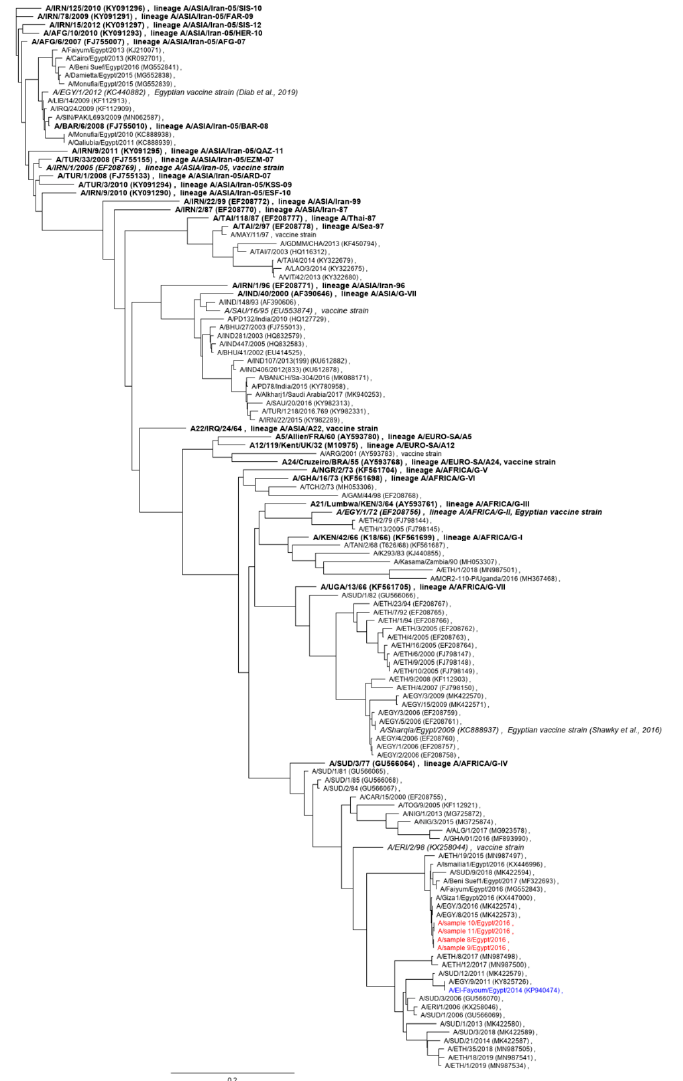
Figure 1. Serotype A 1D (VP1) phylogeny. Newly described viruses from this study are shown in